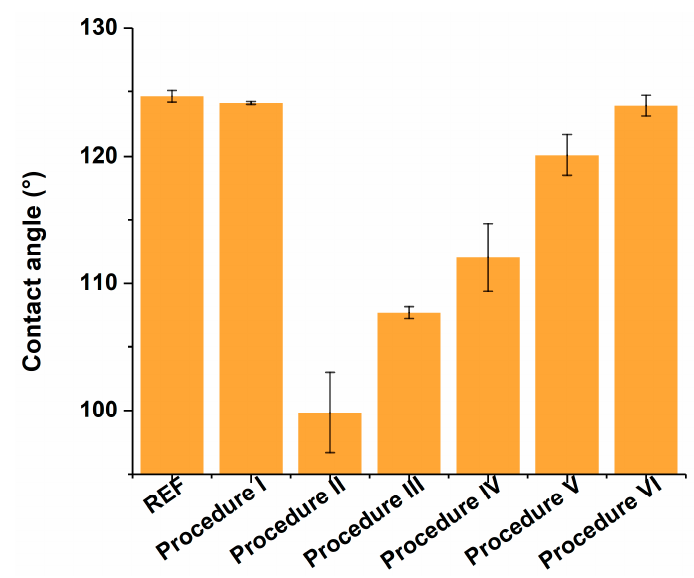
Figure 6. Contact angle measurements of a reference Teflon surface (REF) and the samples fabricated through 6 different procedures (Procedures I to VI). Error bars represent the standard deviation over 4 repetitions.